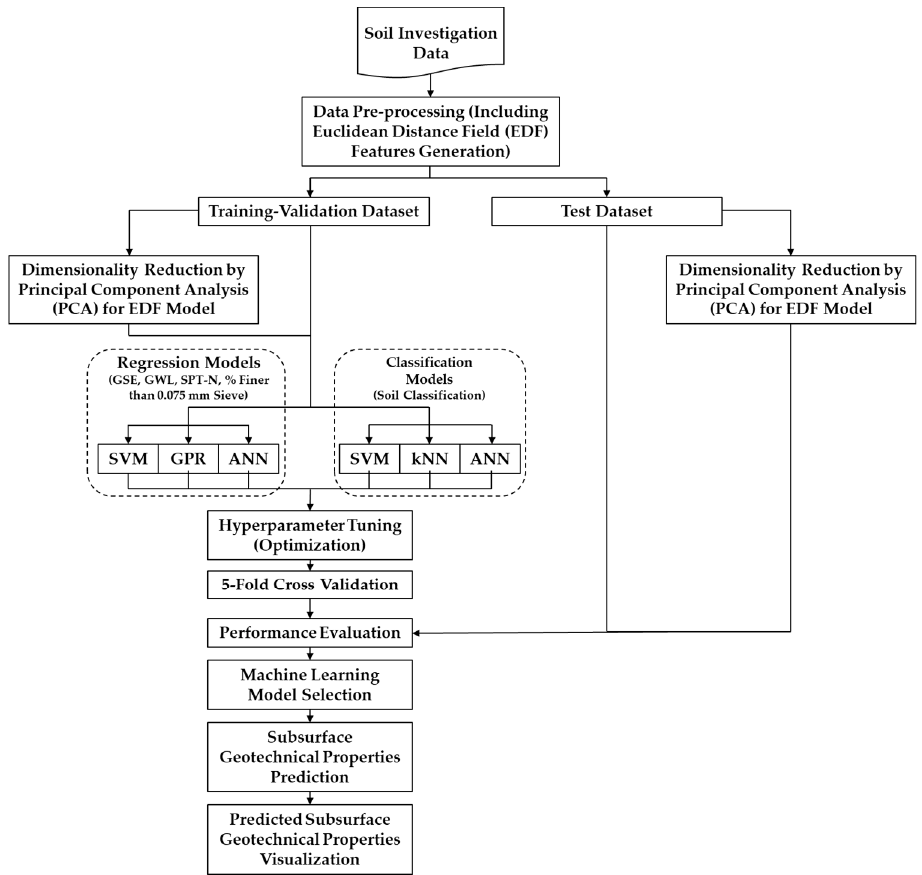
Figure 1. Flow chart of subsurface modeling process of geotechnical properties in this study. Afterwards, the process advances to the machine learning training and